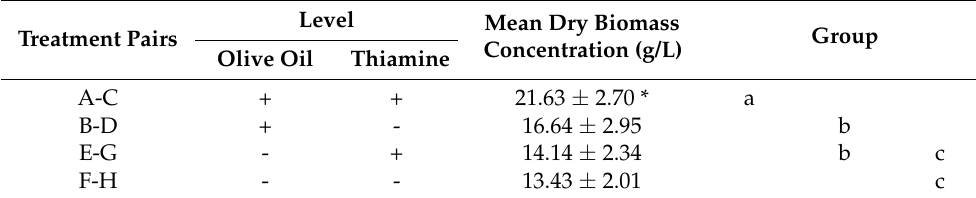
Table 4. Dry biomass concentration of each pair of treatments analyzed by Tukey’s method of multiple comparisons for the olive oil–thiamine interaction. n = 3.